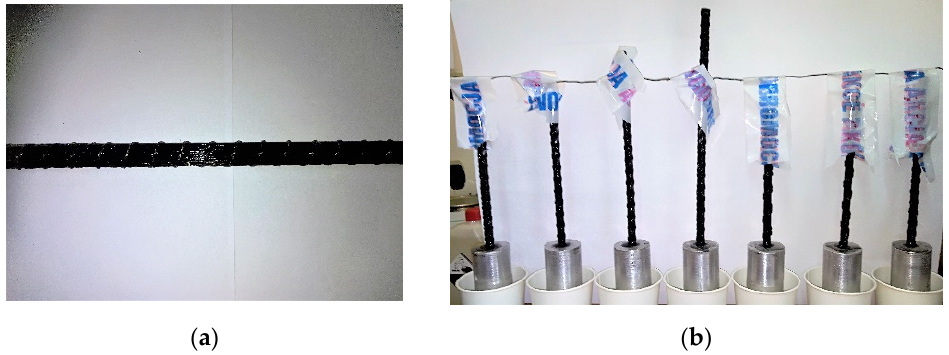
Figure 6. Sample preparation procedure: ( a ) The sample size for testing; ( b ) one-sided anchoring of the bars in a steel sleeves.